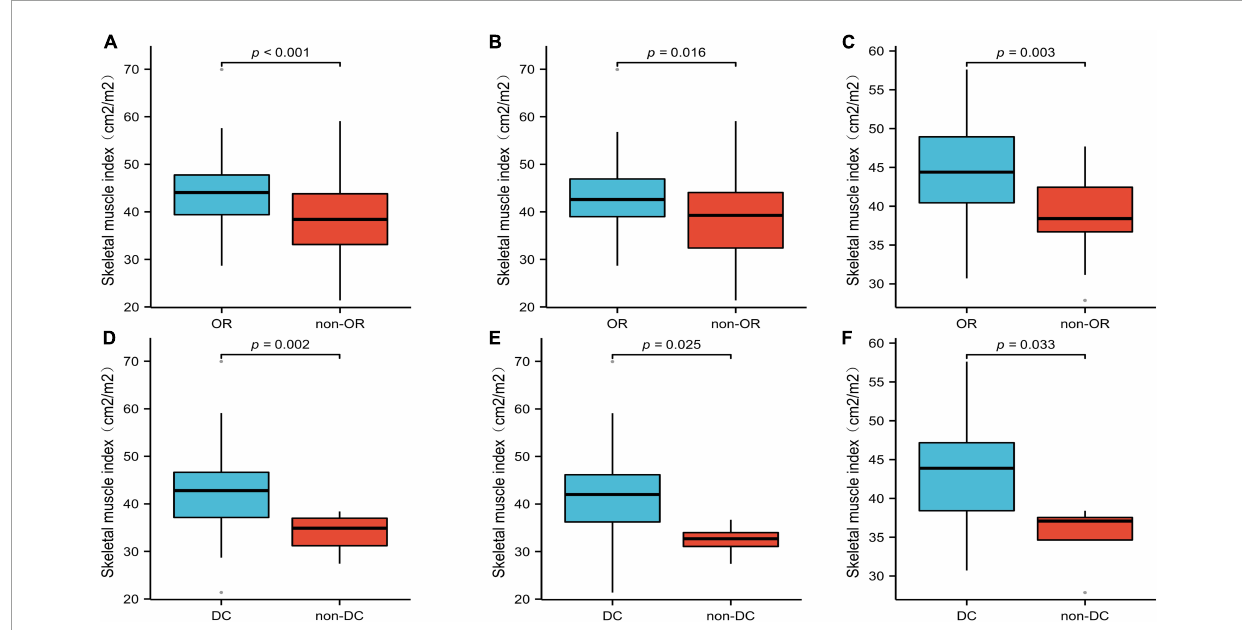
FIGURE5 The mean SMI of the OR and DC groups in all patients (A,D) , patients treated with EGFR-TKIs (B,E) , and patients treated with ICIs (C,F) . SMI, skeletal muscle index; OR, objective response; DC, disease